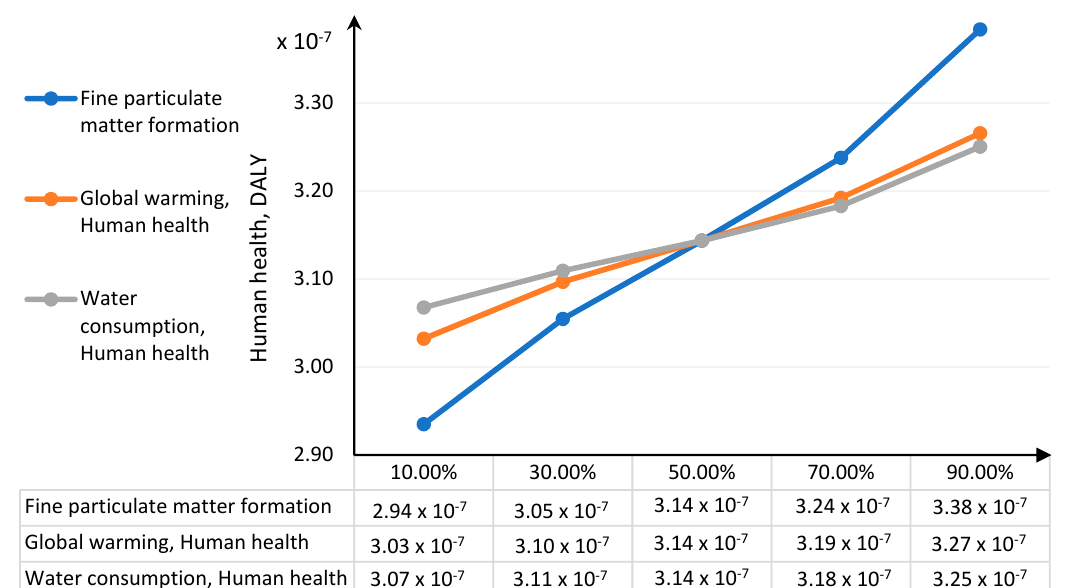
Figure 17. Tornado chart for the forecast of significant categories of impact on human health— error bars show the mean standard error value.